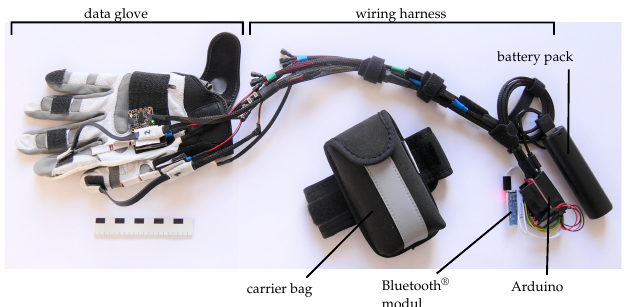
Figure7. OverviewofSenGlove. Realizationshownforamedium-sizedrighthandwithtwofingers Figure 7. Overview of SenGlove. Realization shown for a medium-sized right hand with two fingers equippedwithsensors. CarrierbagusedtostorethebatterypackandtheArduinocanbestrapped totheupperarm. equipped with sensors. Carrier bag used to store the battery pack, and the Arduino can be strapped to the upper arm.